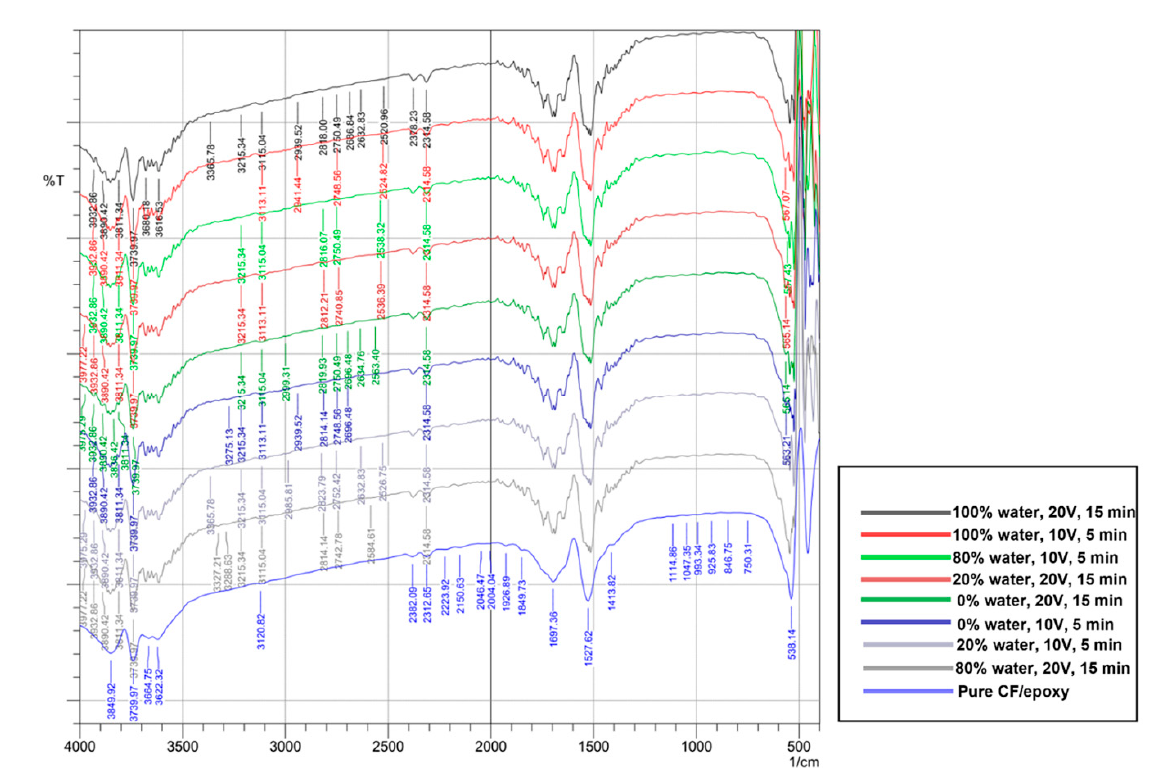
Figure 3. The FTIR analysis of the composites.